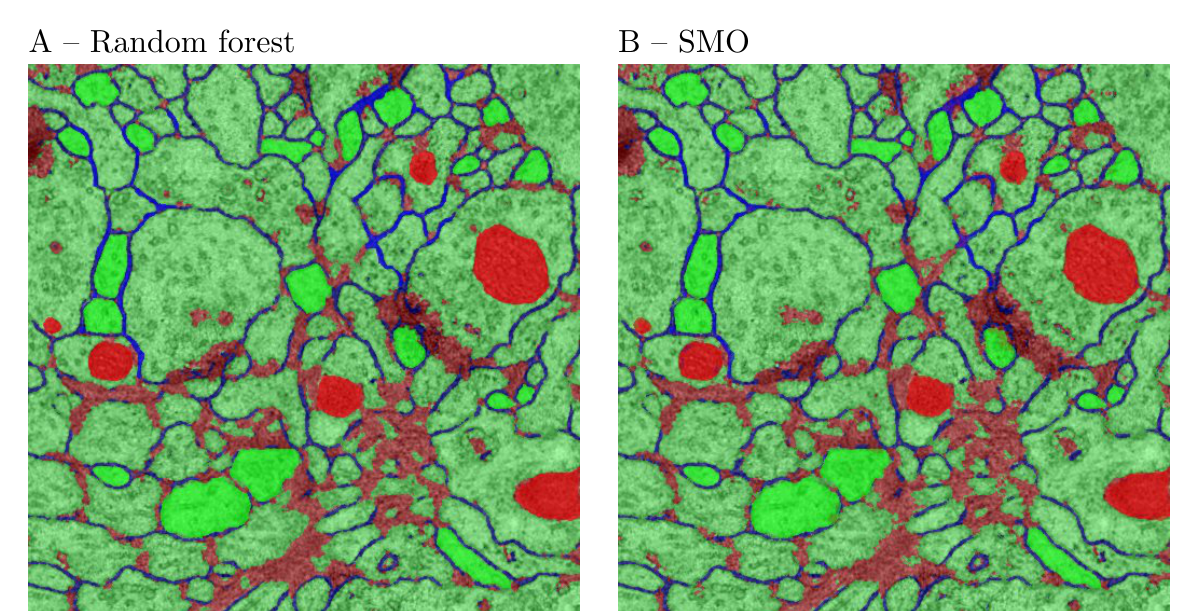
Figure 9. Characteristic features compared to the segmentation outcome. ( A ) RF classifier. ( B ) SMO classifier.